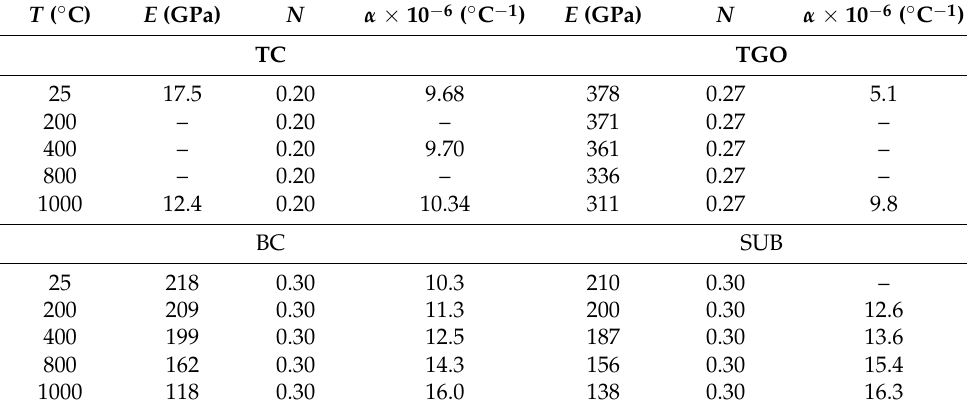
Table 1. Temperature-dependent thermal expansion coefficient α , Young’s modulus E and Poisson ratio ν data used for TC, TGO, BC, and SUB [36,64].